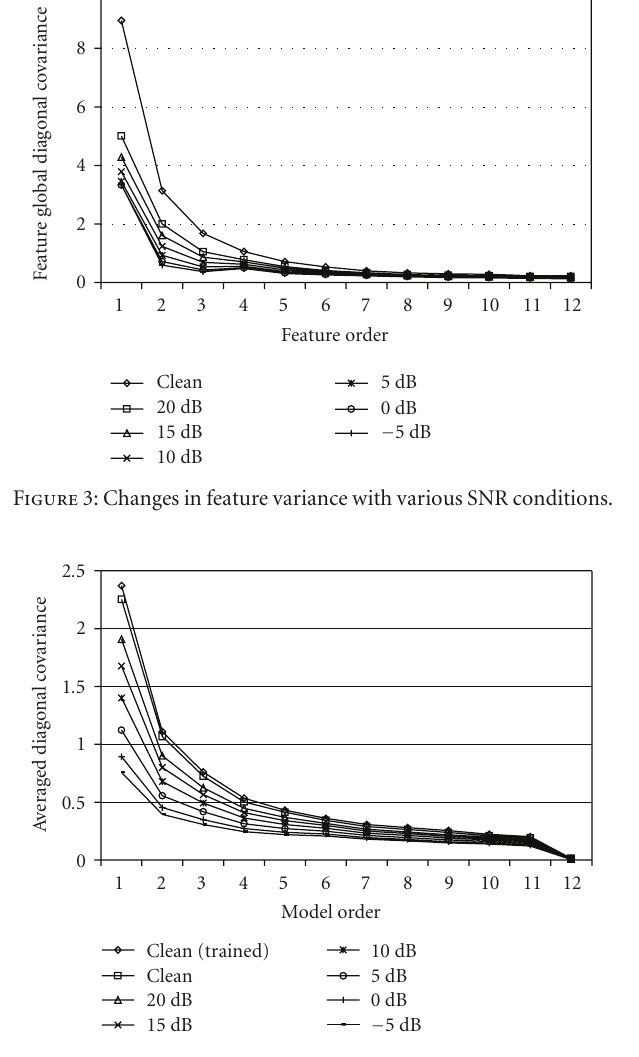
Figure 4: Changes in average values of covariance models after